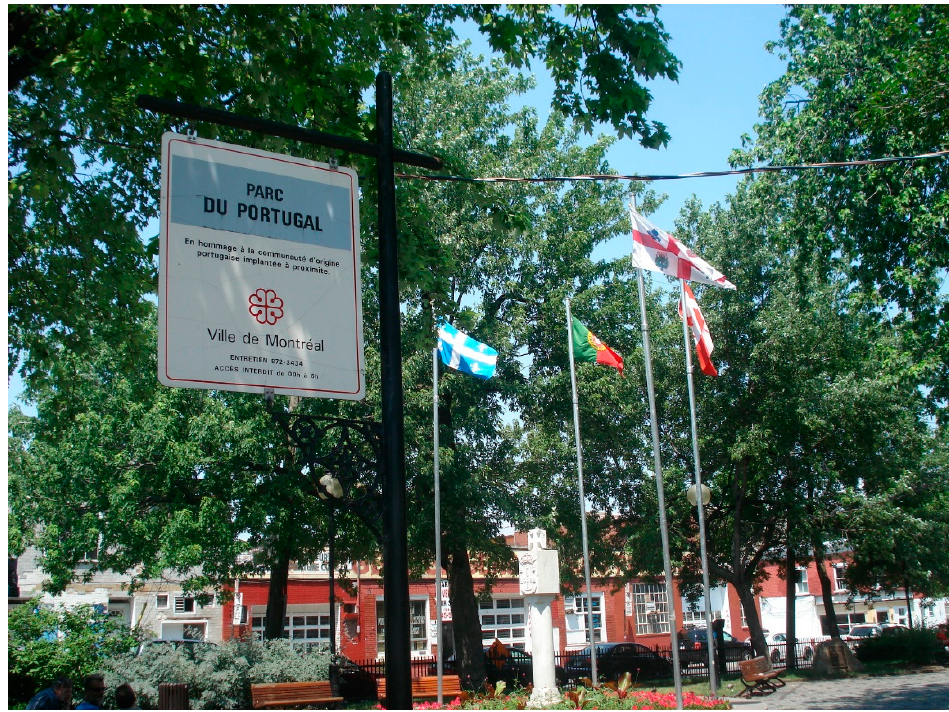
Figure 1. Parc du Portugal , Saint-Laurent/Marie-Anne. The park was dedicated to Portuguese immigrants and their com- munity.